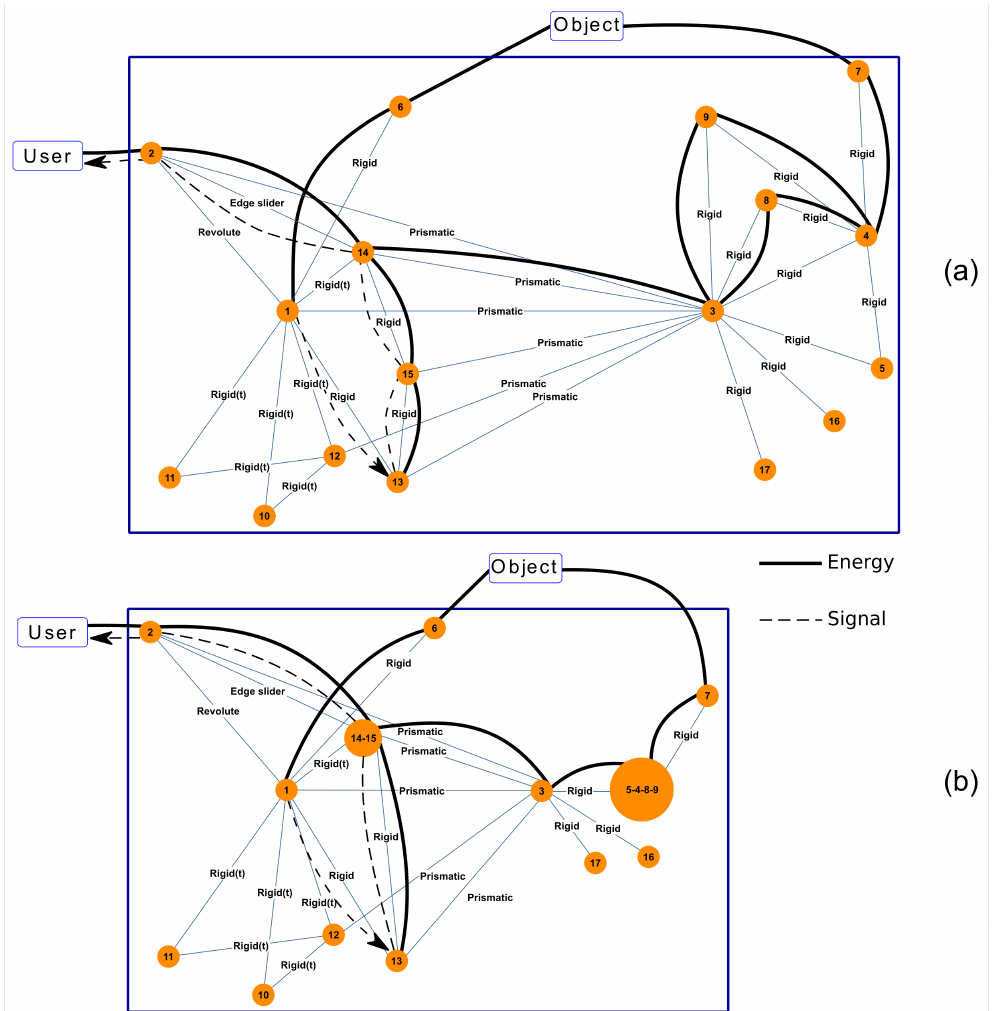
Figure 9. Product architecture showing part-to-part kinematic pairs along with functional flows: ( a ) initial architecture and ( b ) minimized